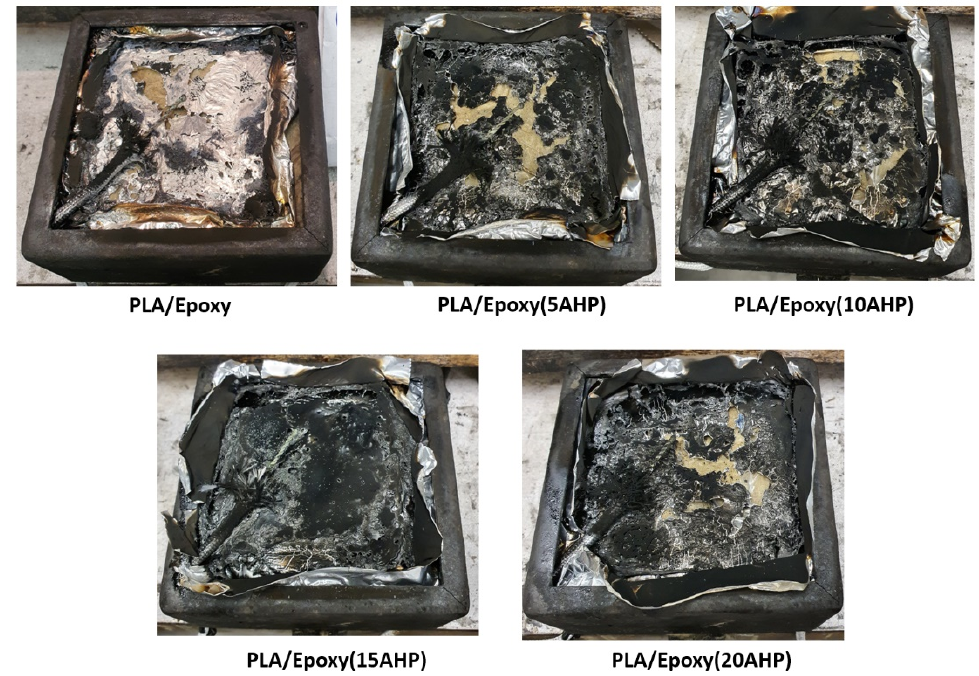
Figure 9. Pictures taken from samples to illustrate the aspect of residual products after MLC test- ing.